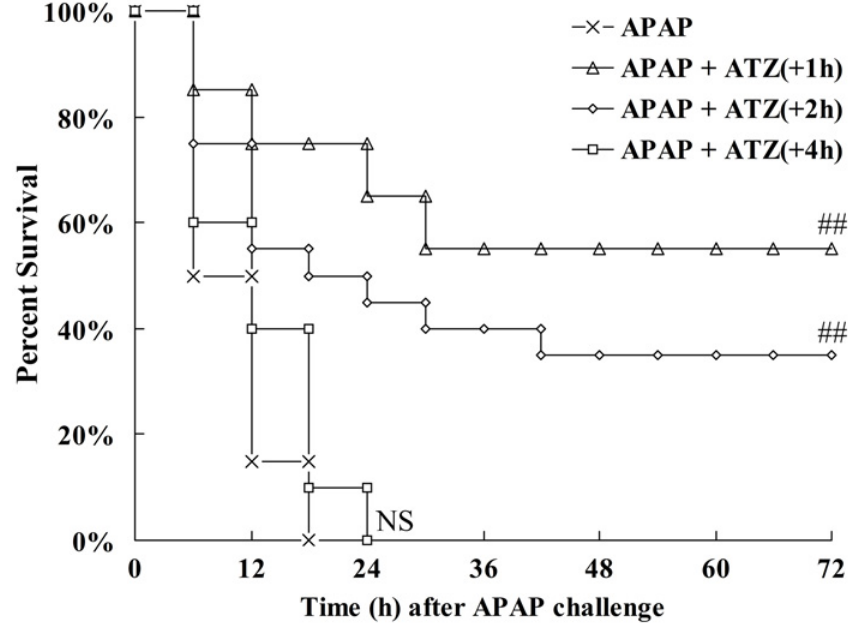
Fig 9. Posttreatment with ATZ decreased the mortality induced by APAP. Mice were treated with vehicle or ATZ (500 mg/kg) at 1 h, 2 h or 4 h after APAP exposure. Survival was monitored and the percent survival rate was expressed as Kaplan-Meier survival curves (n = 20). NS P > 0.05, ## P < 0.01, as compared with the APAP group.